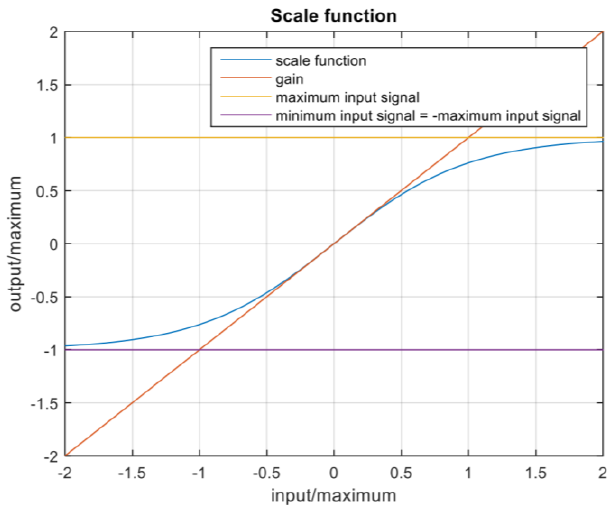
8 of 17 Figure 5. Summary of the six tasks’ conditions based on a combination of different track designs and motion cues levels used in our experiment. Before each round, the motion platform’s parameters were tuned to an appropriate